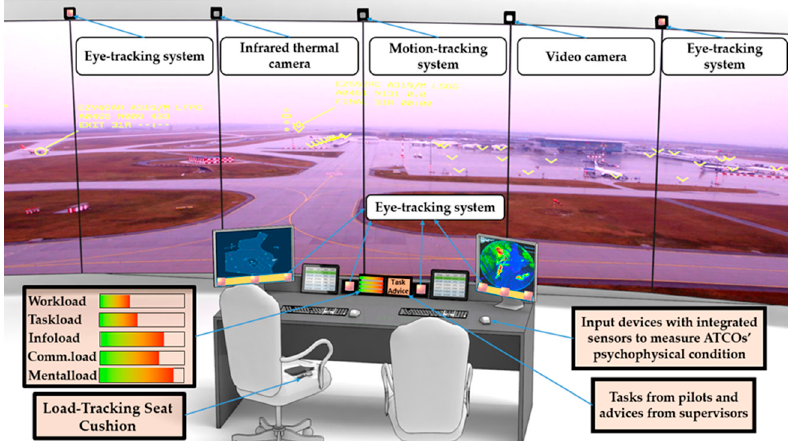
Figure 17. Future load monitoring and management design in Air Traffic Management (ATM).